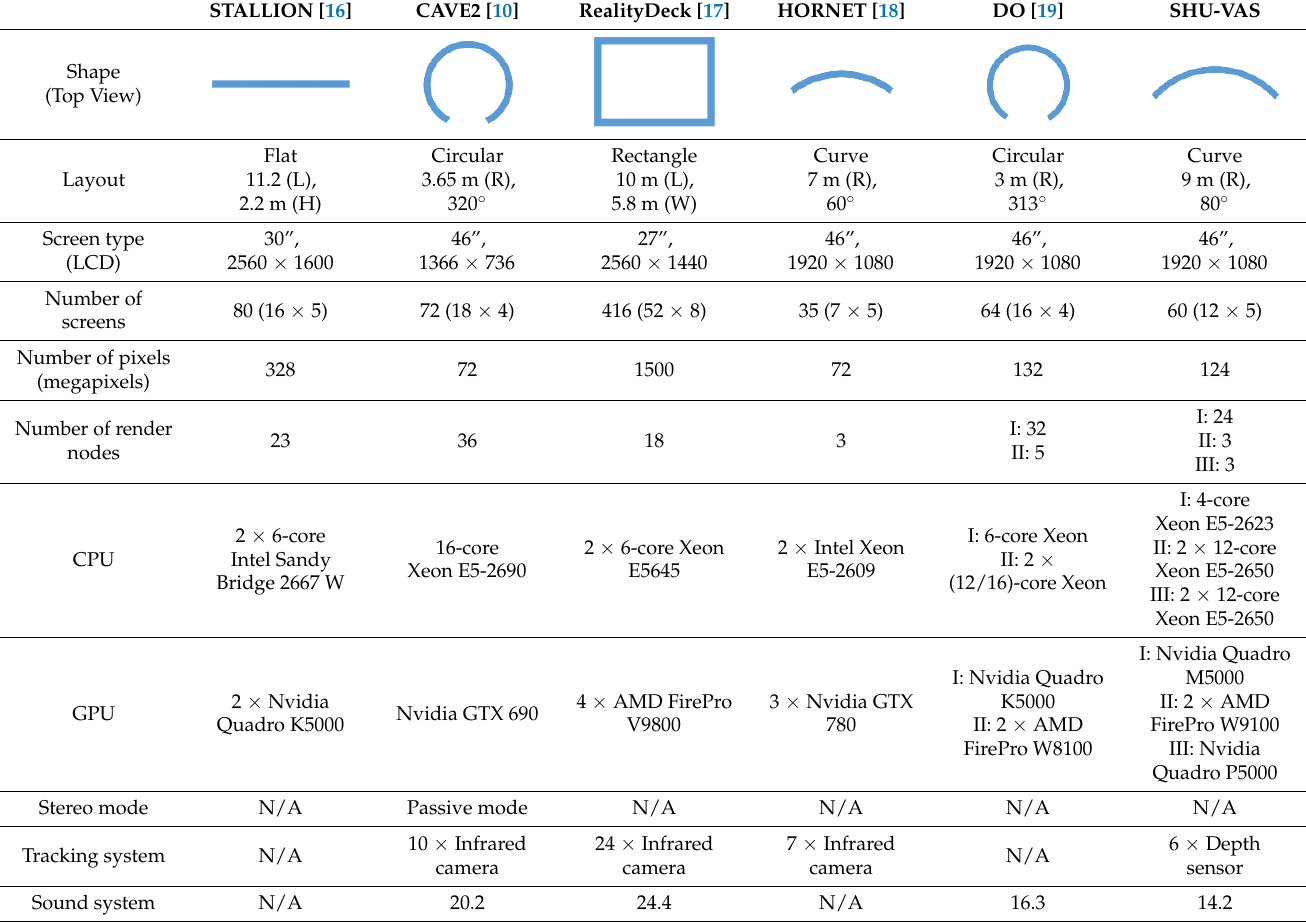
Table 1. Configuration of large-scale high-resolution display wall systems.